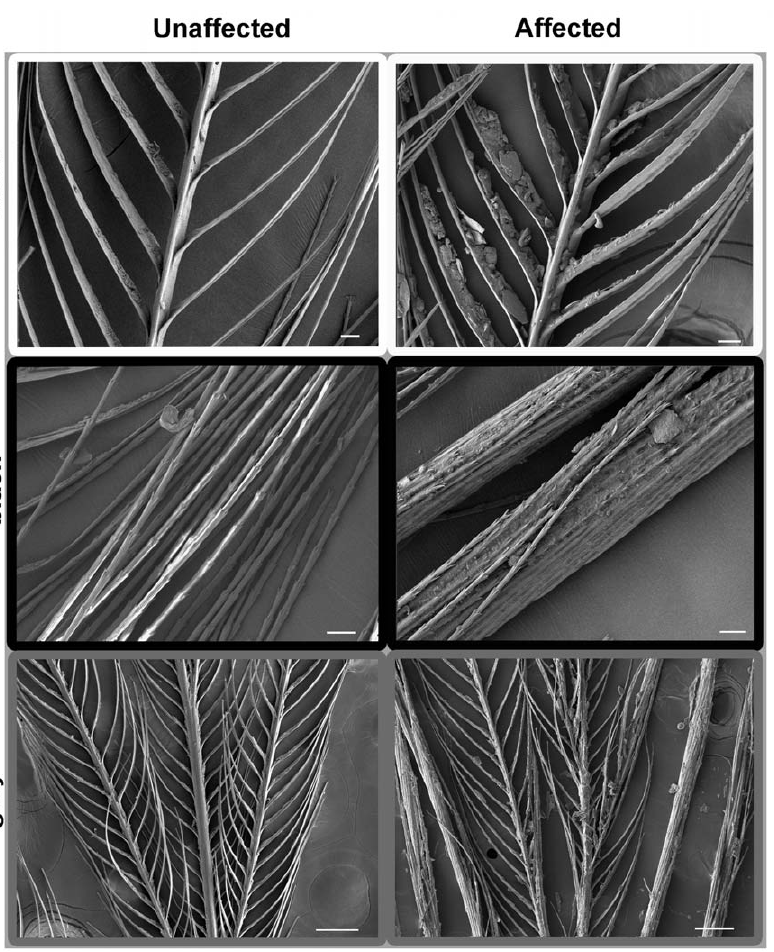
Figure 2. Feather microstructure of affected and unaffected birds. Examples of SEM micrographs of white cheek feathers (upper panels) black bib feathers (middle panels) and grey mantle feathers (lower panels) from black-capped chickadees unaffected (left) and affected (right) by avian keratin disorder. Scale bars are 20 m m.